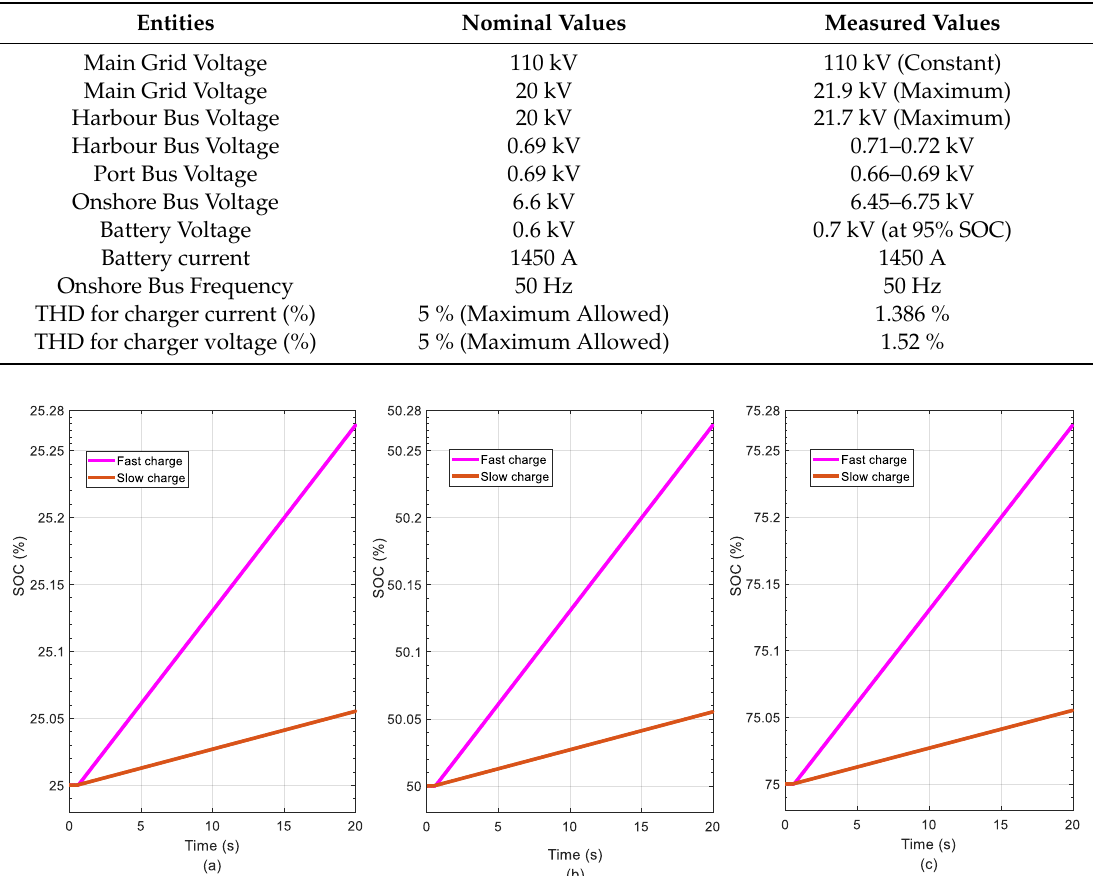
Figure 7. Rate of change of SOC of batteries in configurations A and D, ( a ) When BESS is at 25% SOC ( b ) When BESS is at 50% SOC ( c ) When BESS is at 75% SOC.